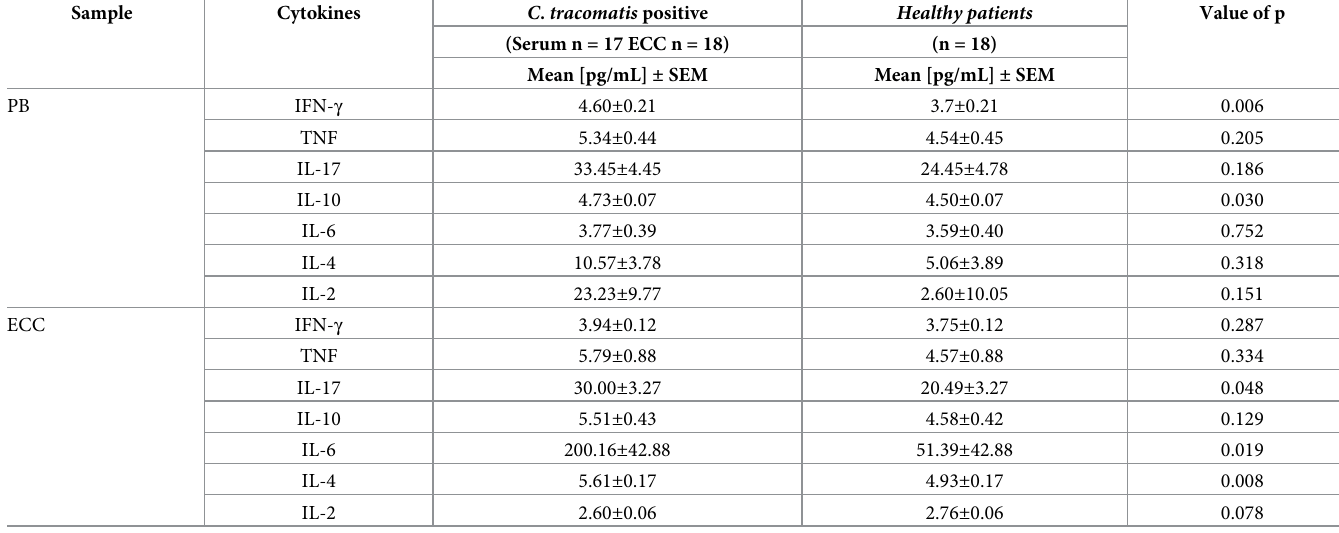
Table 2. Cytokine levels in the exfoliated cervical cell (ECC) and peripheral blood (PB) of patients with Chlamydia trachomatis infections and group control (no infections).